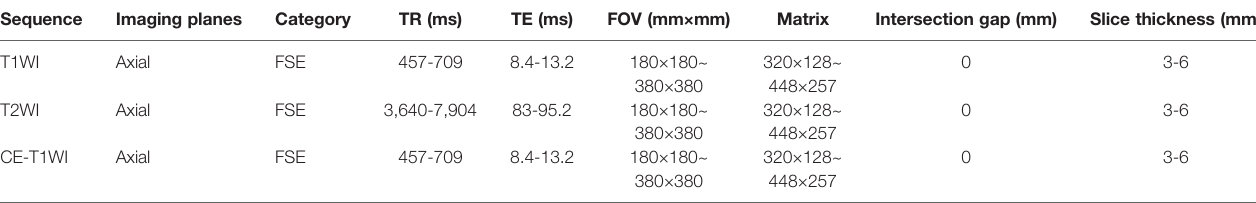
TABLE 4 | The detailed scan parameters of four MRI scanners.